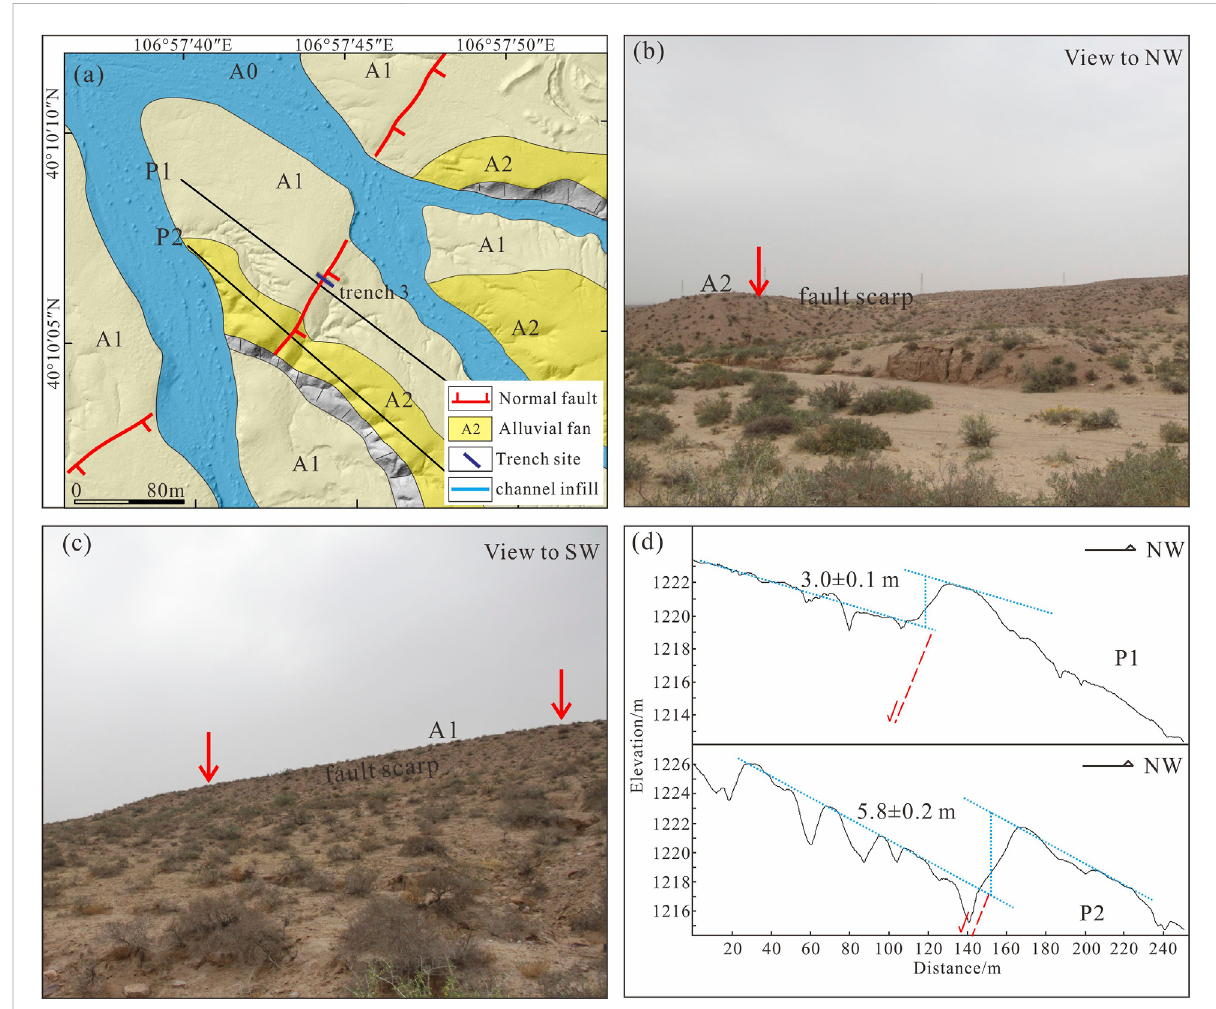
FIGURE 6 (A) Interpretationofthehillshademapatthetrench3site; (B) faultscarpoftheA2alluvialfan; (C) faultscarpoftheA1alluvialfan; (D) topographic pro fi les across the fault scarp at the locations shown in panel (A) determined using a ~0.2 m resolution